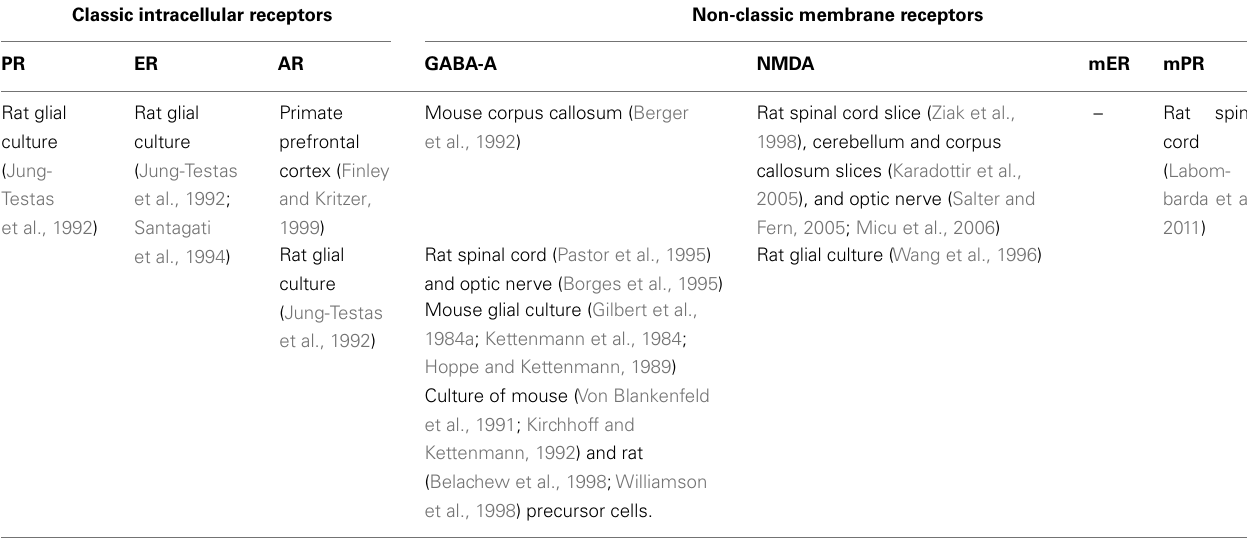
Table 2 | Distribution of major classic and non-classic receptors for neurosteroids in oligodendrocytes. Classic intracellular receptors